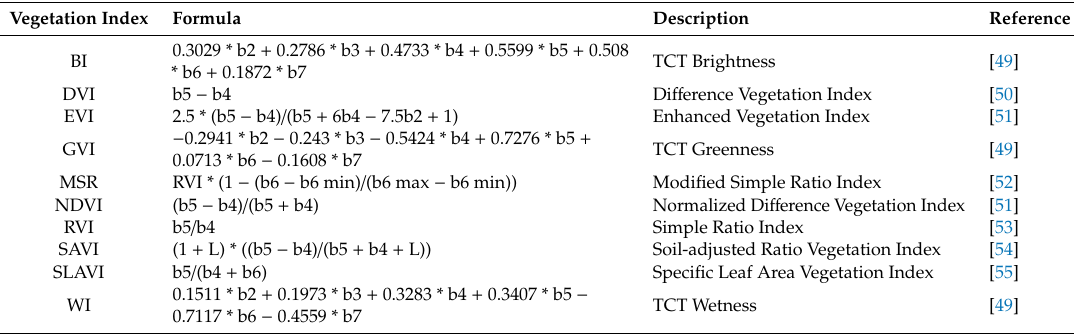
Table 3. Vegetation indices and formula based on Landsat 8 OLI data. Tasseled Cap Transformation is abbreviated as